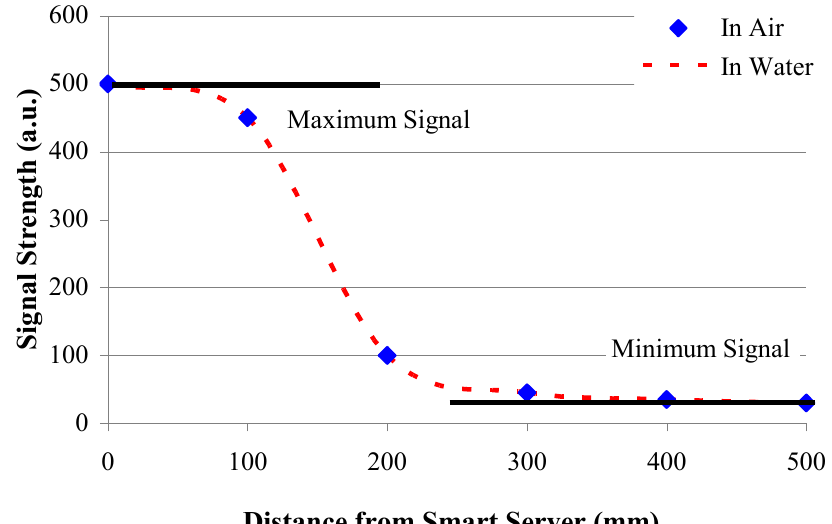
Figure 15. The signal strength as detected by the Smart Server as the Pig is moved along the pipe in air and in